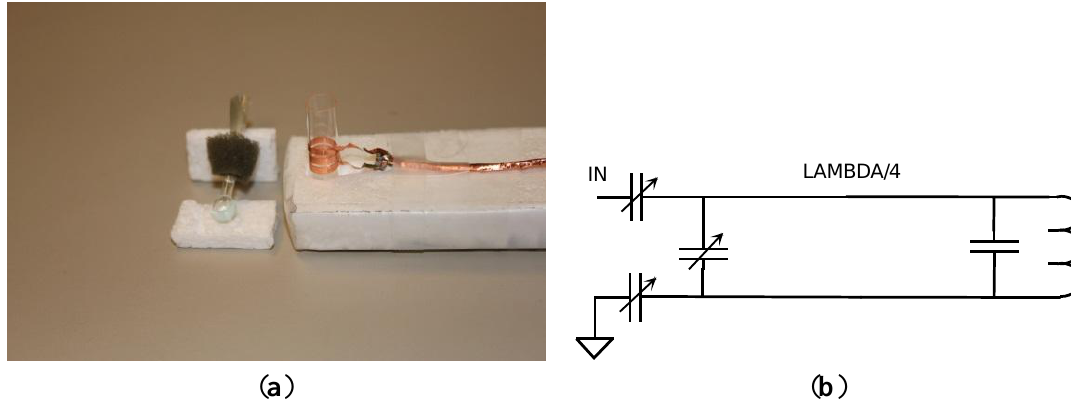
Figure 5. ( a ) Photograph of the sample and coil used for the GIRF experiments. The coil is wound around an 8 mm NMR tube; ( b ) Diagram of the coil and capacitor, with the adjustable tuning capacitors situated a quarter wavelength away from the